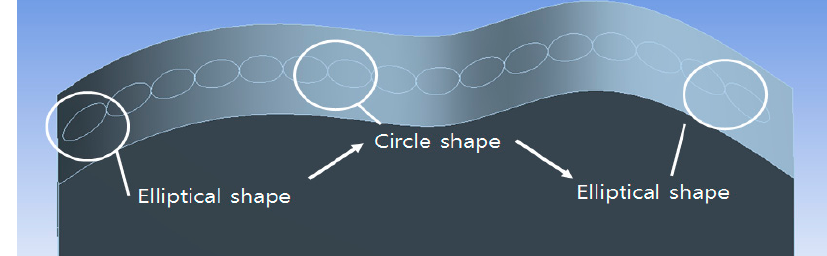
Figure 12. Changes of laser heat source shape according to curved surface.